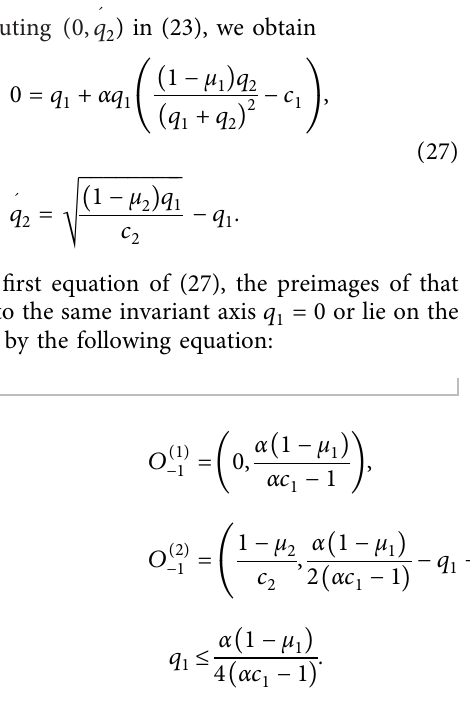
Figure 6: (a and b) Phase plane corresponding to the parameter values c to the divergent and infeasible trajectories, while the other two colors are for the basin of attraction of Nash point and the period 2-cycle coexisting with